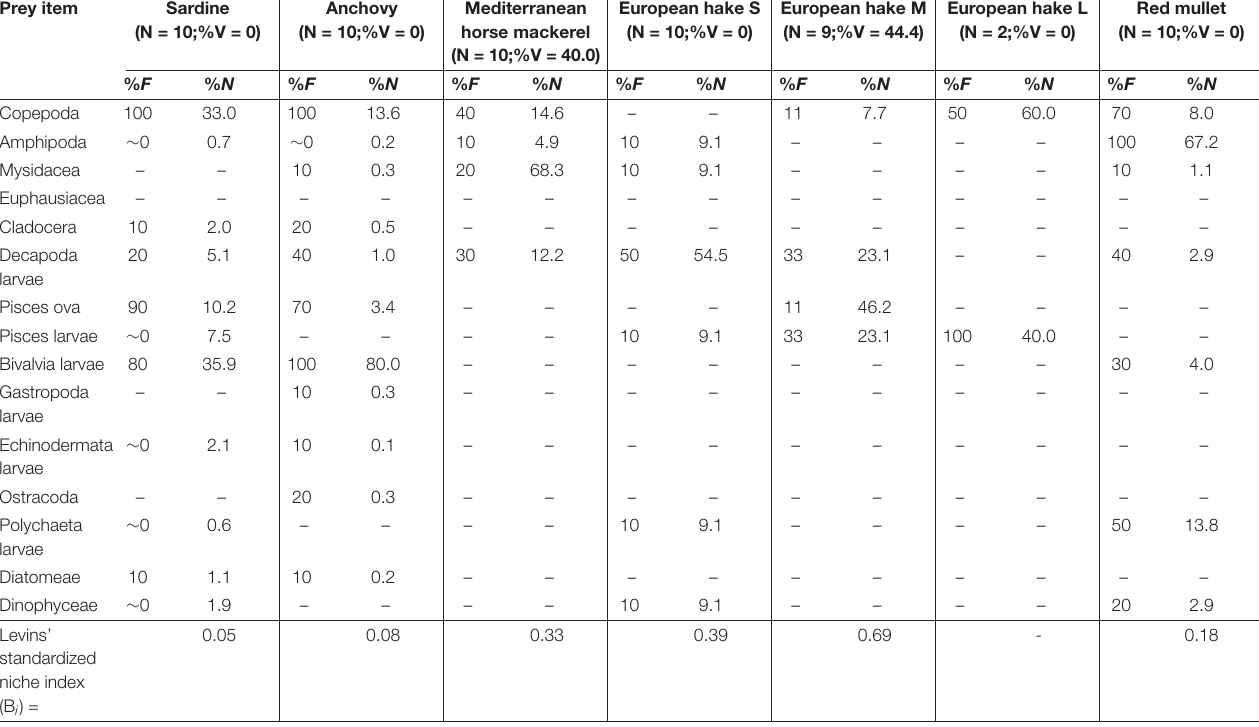
TABLE 1 | Frequency of occurrence (%F) and abundance (%N) of prey items found in the sardine, anchovy, Mediterranean horse mackerel, European hake [by size classes: small (S: TL < 20.0 cm), medium (M: 20.1 cm < TL < 30.0 cm) and large (L: 30.1 cm > TL)] and red mullet collected in the Northern area (Kvarneri´c Bay) of eastern Adriatic Sea during MEDITS survey (June–July, 2018) along with number of analyzed specimens ( N ), its vacuity index (% V ) and Levins’ standardized index (B i ). Prey